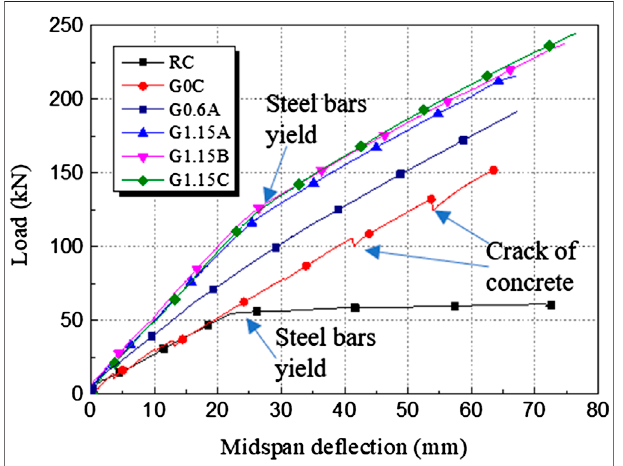
FIGURE 7 | Load-midspan de fl ection